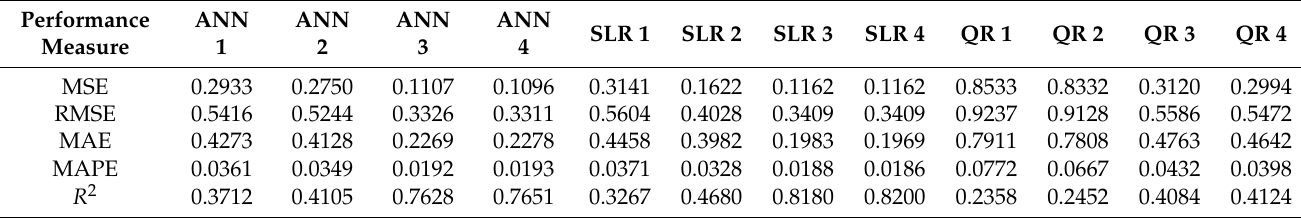
Table 4. Comparison of the performances of artificial neural networks (ANNs), semi-log regressions (SLRs) and quantile regressions (QRs) for dataset 1.